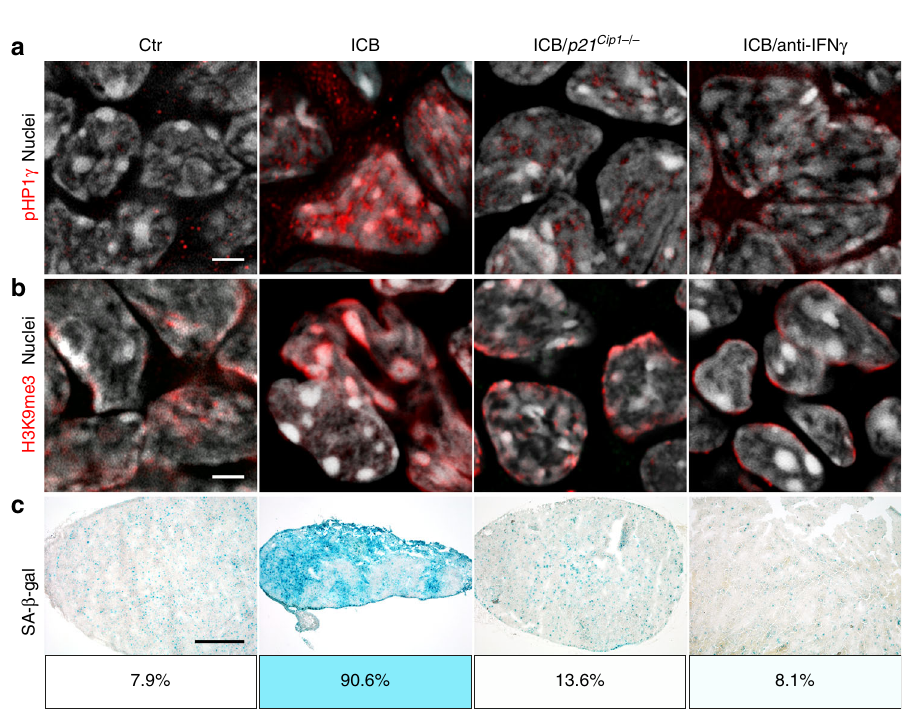
Fig. 9 IFN- γ and p21 Cip1 -dependent senescence induction in B cells of λ - MYC mice during ICB. a – c Fresh frozen cryostat sections of representative lymph nodes of λ - MYC or λ - MYC . p21 Cip1 − / − mice. λ - MYC mice were controls (Ctr) or treated with anti-CTLA-4 and anti-PD-1 mAbs (ICB) or anti-CTLA-4, anti-PD- 1 and anti-IFN- γ mAbs (ICB/anti-IFN- γ ), or λ - MYC . p21 Cip1 − / − mice were treated with ICB (ICB/ p21 Cip1 − / − ). pHP1 γ (red), nuclei (white) ( a ). H3K9me3 (red), nuclei (white) ( b ). Representative microscopic images of SA- β -gal activity at pH5.5 and percentage of SA- β -gal positive tumour cells in each tumour ( c ). The colour evaluation and calculation of the SA- β -gal + cells are described in Supplementary Fig. 2 and Methods. Scale bars 2 μ m ( a , b ), 1000 μ m ( c ). The SA- β - gal data are representative for three individual tumours. Immune fl uorescence was performed in one to two representative tumours from Fig. grids and analysed using a Zeiss LIBRA 120 transmission electron microscope (Carl Zeiss, Oberkochen, Germany) operating at 120 kV. Cell culture . Adherent primary murine RT2-cancer cells (described above), B16- F10 melanoma cells (catalogue number CRL-6475, ATCC) and B16-OVA mela- noma cells (gift from R. Dutton, Trudeau Institute, New York, USA) were cultured in Dulbecco ’ s Modi fi ed Eagle ’ s Medium (DMEM) supplemented with 10% foetal calf serum (FCS), nonessential amino acids, sodium pyruvate, antibiotics, and 50µM 2-mercaptoethanol at 37°C and 7.5% CO 2 . The murine melanoma cell lines B16 and B16-OVA were cultured in DMEM medium, containing 10% FCS and penicillin/streptomycin (100 U ml − 1 ; all from Biochrom AG), at 37 °C and 5% CO 2 . The human patient-derived xenograft (PDX) cell lines were cultured in RPMI-1640 medium supplemented with 10% FCS, nonessential amino acids, sodium pyruvate, antibiotics, and 5µgml − 1 Plasmocin (Invitrogen) to treat infections of clinical samples, at 37 °C and 5.0% CO 2 . Cell line supernatants were tested with a mycoplasma detection PCR Venor Ge M (Minerva Biolabs GmbH) regularly every 4 weeks. Generation of primary murine RT2- or RT2. Stat1 − / − -cell lines . RT2-cancers were isolated from the pancreas of female RT2 or RT2. Stat1 − / − mice by intraductal injection of collagenase (1mg ml − 1 , Serva, Heidelberg, Germany) 25,31 . After injection, the pancreata were harvested, digested in collagenase solution at 37°C for 10min, and then mechanically disrupted. Whole encapsulated tumours were separated under a dissection microscope (Leica Microsystems) and further